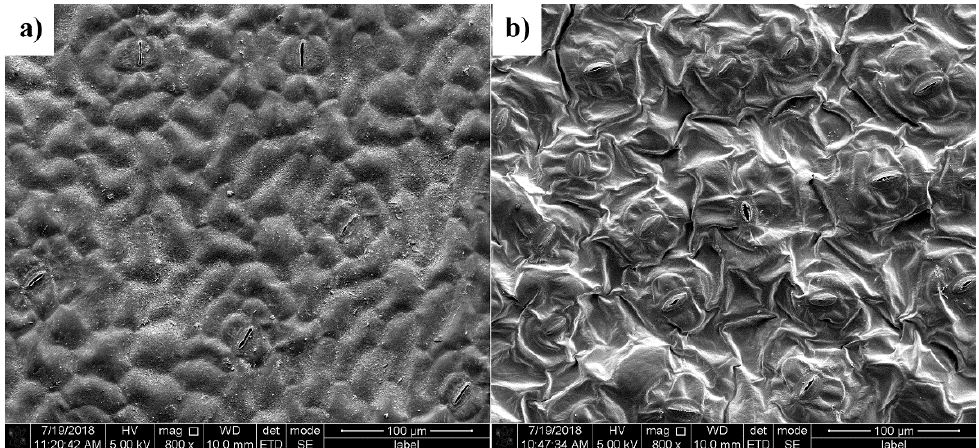
Figure 3. Field emission scanning electron microscopy (FESEM) micrograph of the surface leaves: ( a ) control; ( b ) Ni exposure.